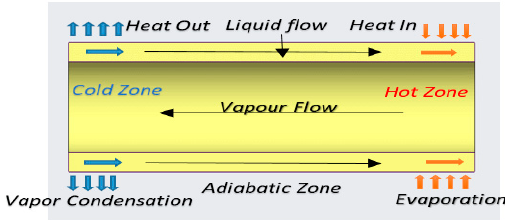
Figure 3. The heat pipe working principle.